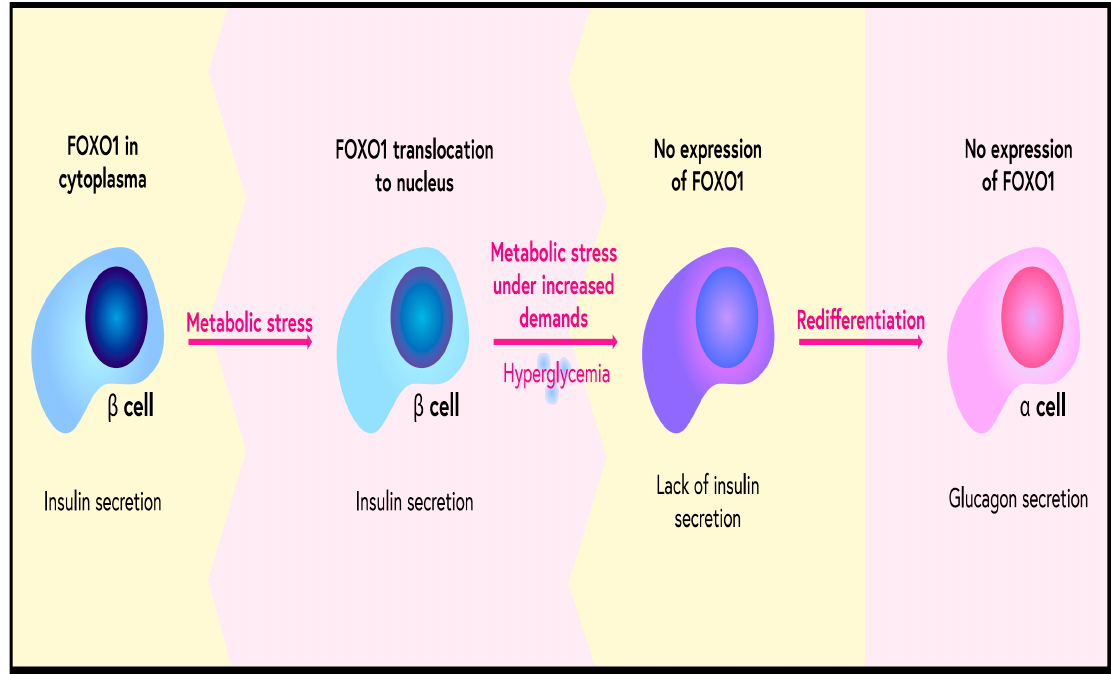
Figure 2. Role of FOXO1 in metabolic stress. FOXO1 is translocated into the β -cell nucleus during metabolic stress. However, severe metabolic stress and increased demands could lead to a lack of FOXO1 and insulin expression by β -cells. In such conditions, β -cells undergo a redifferentiation process. Some start to remind α -cells as they start to express glucagon.